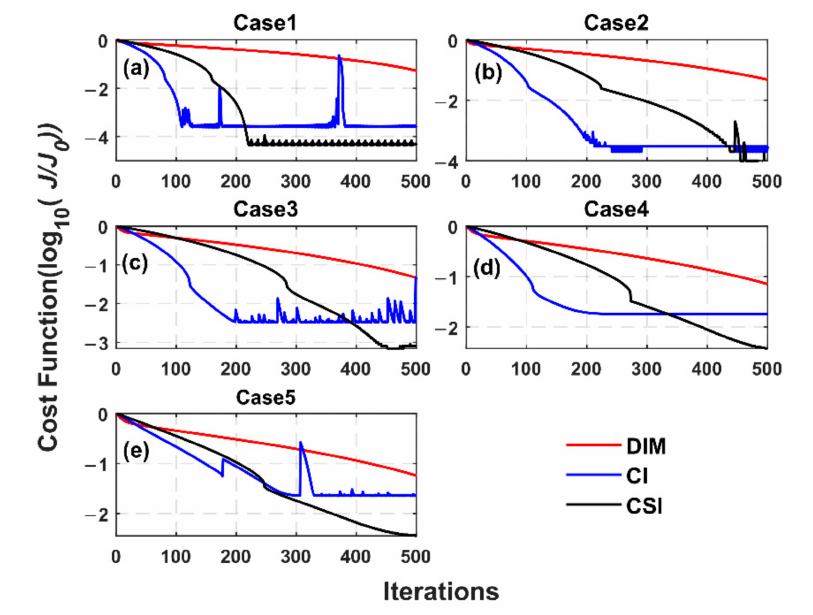
Figure 2. The variation curves of cost functions with different inversion schemes in Group 1. ( a – e ) correspond to Case 1–Case 5,